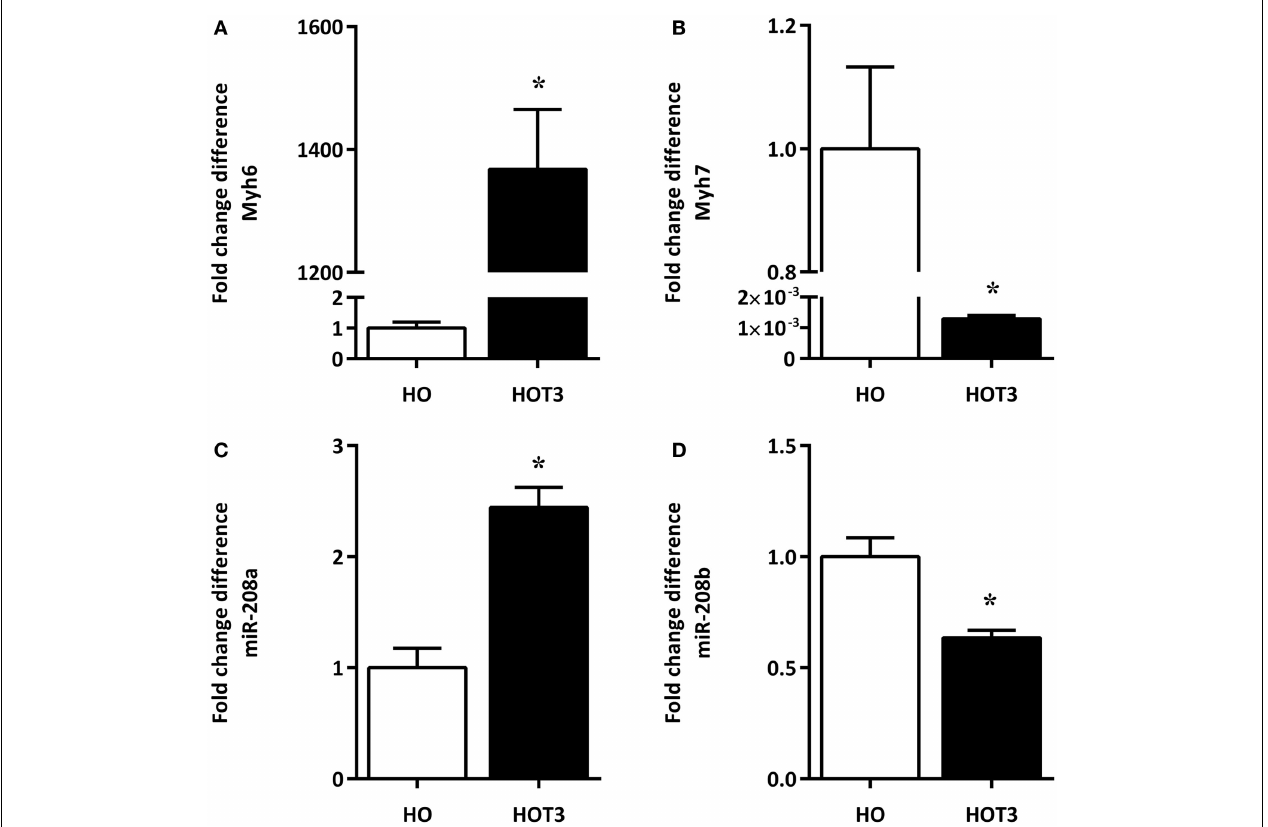
evident from the shift in expression of Myh6 [ (A) , solid bar] and Myh7 [ (B) , solid bar] as a result ofT3 treatment. MiRNAs 208a and 208b are located within Myh6 and Myh7 .The expression pattern of miR-208a (C) and miR-208b (D) in these conditions is similar to the pattern of their host genes. HO set to 1, values are means ± SEM; * p <